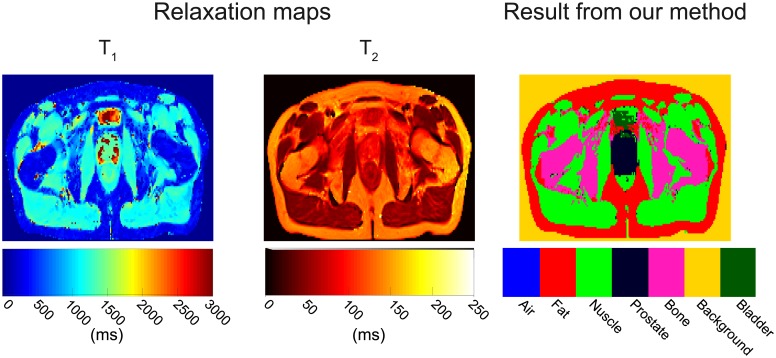
Relaxation maps and classification results of volunteer 20.The T1 relaxation map shows heterogeneous values for the bladder and prostate areas, and homogeneous non-distinctive areas for fat and bone marrow which complicate the classification process. The T2 map only shows two discernible areas: 1) fat-bone marrow-prostate-bladder (≥100ms) and 2) muscle (<100 ms) adding additional complexity to the classification process. Nevertheless, the SVM classifies accurately labeled the different areas: prostate = 89.1%, fat = 100%, muscle = 98.8%, bone marrow = 89.7%, bladder = 71.9% and air was not present. All features were used to perform the classification.